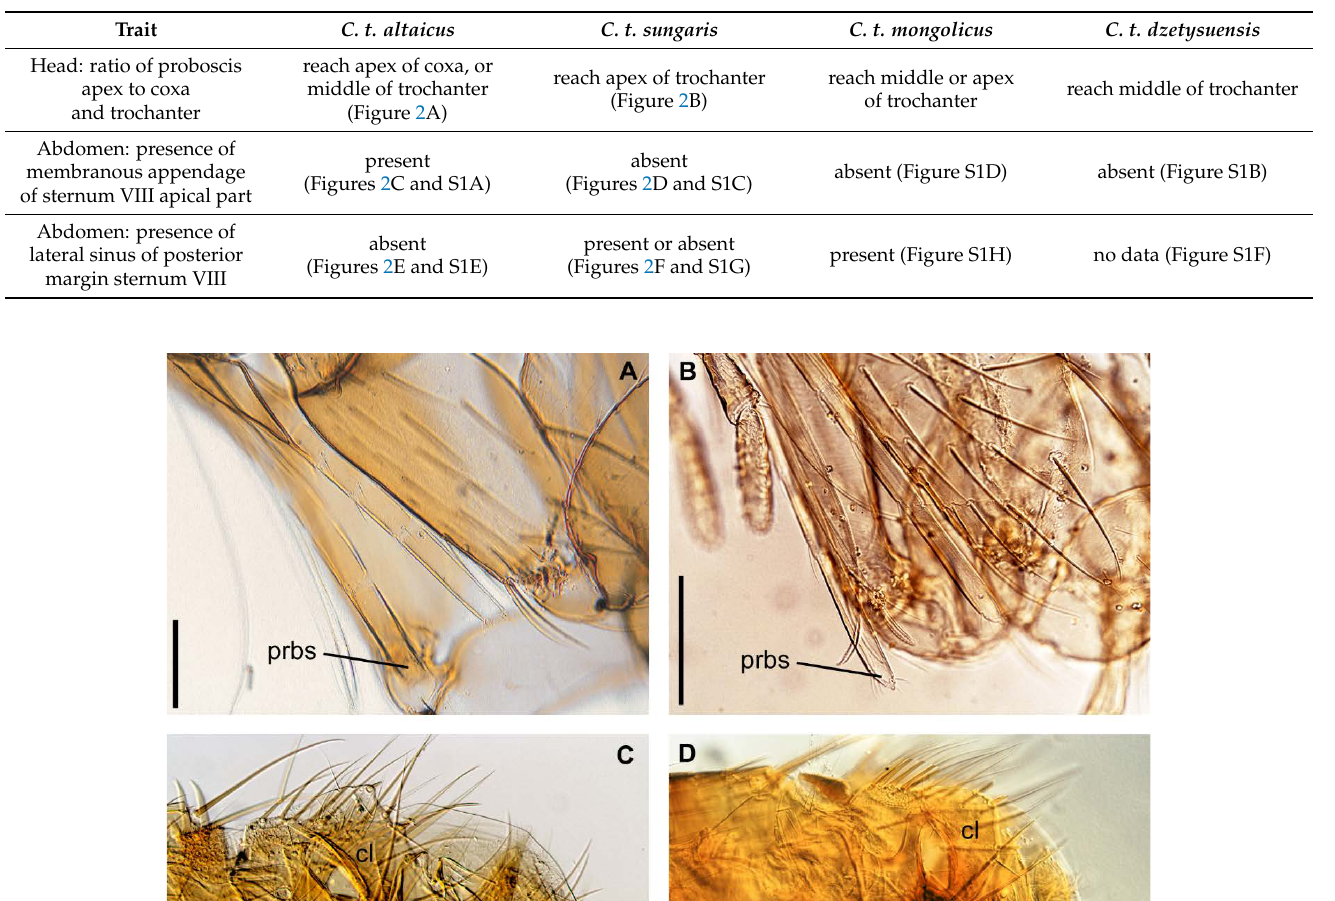
Table 2. Morphological delimitation traits of four Citellophilus tesquorum subspecies.